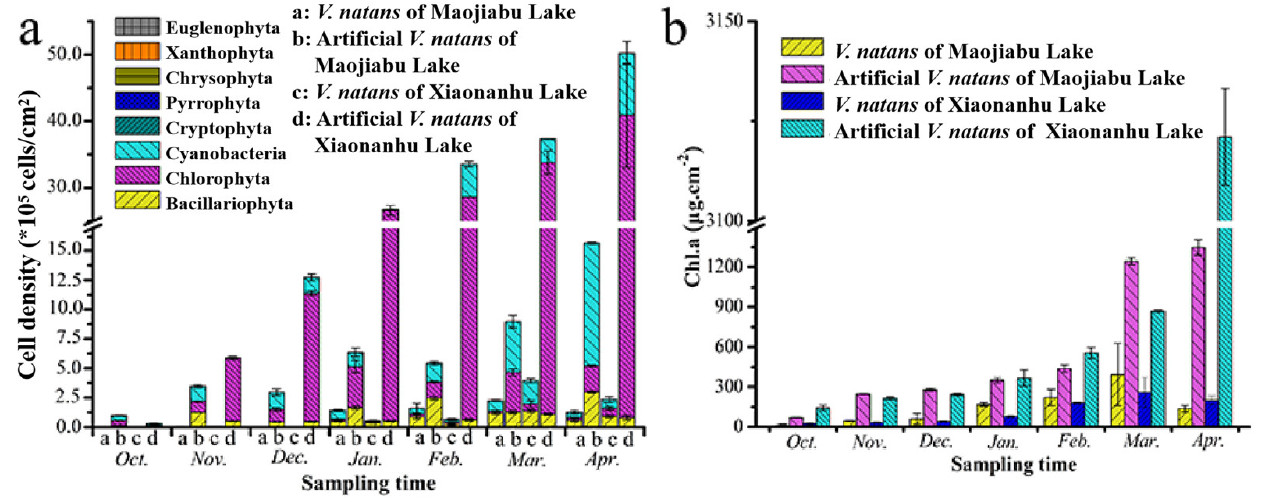
Figure 4. Periphytic-algae biomass on V. natans and artificial V. natans ; ( a ) Cell density; ( b ) Chl. a content. Error bars show the standard deviations (n = 3).